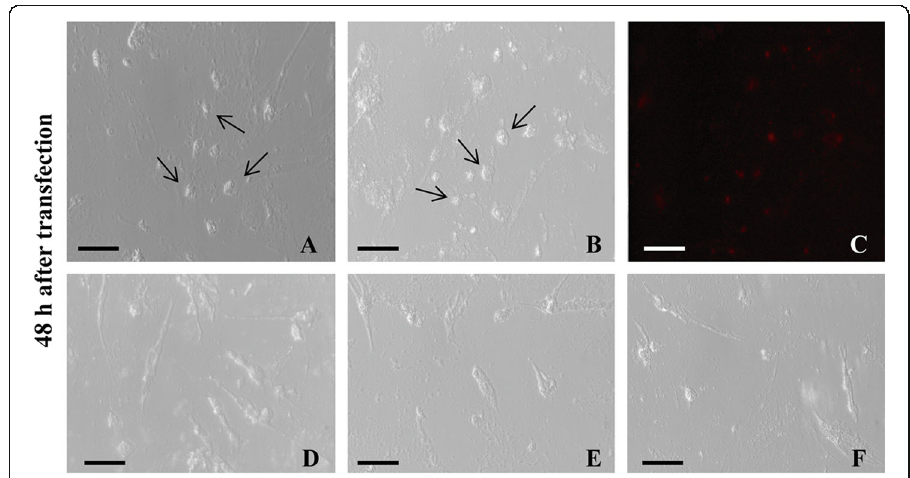
Fig. 4 The effect of mouse Oct4 knockdown in CCE cells. a and b CCE cells were transfected without ( a ) or with ( b ) the negative control alone for 48 h. c More than 85% of the cells were successfully transfected with Alexa Fluor Red Fluorescent Oligo. d , e and f The self-renewal and undifferentiated state of CCE cells were not maintained when transfected with the three siRNA of Oct4 – R1 ( d ), R2 ( e ) and R3 ( f ) when tested 48 h after the transfection. The arrows indicate the normal CCE mouse ES cells. The images were photographed with Leica DMI3000B at 200× magnification. Scale bar =20 μ